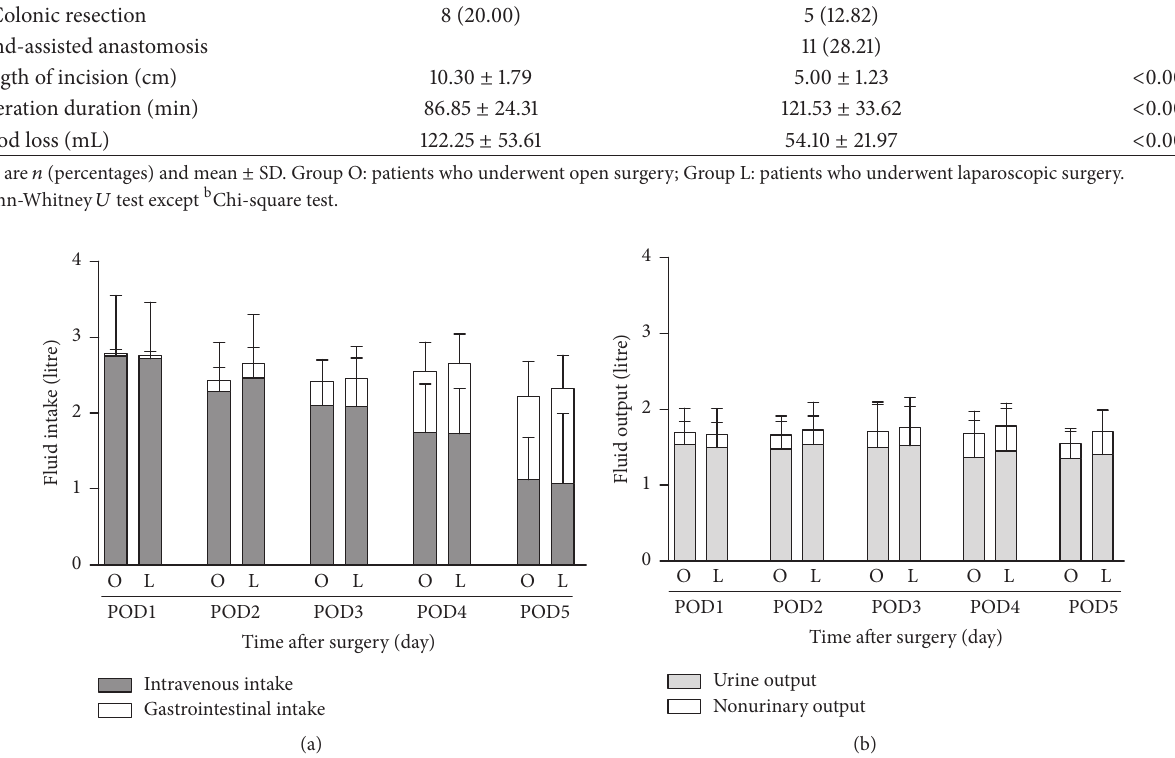
Figure 1: Postoperative fluid management. O: Group O; L: Group L. POD: postoperative day. (a) Daily volume of fluid intake after surgery including intravenous fluid intake and gastrointestinal fluid intake. (b) Daily volume of fluid output after surgery including urine output and nonurinary output. “Nonurinary output” included digestive fluid, drainage fluid, and feces. There was no difference between